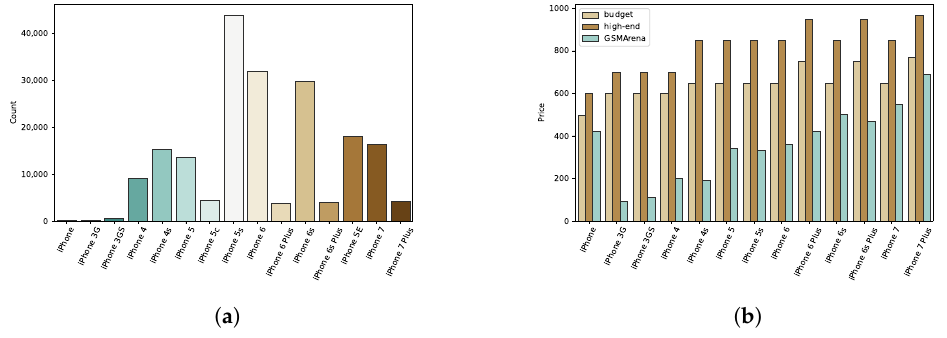
Figure A2. Based on the “April 2017” dataset, the different iPhone models in use are also displayed ( a ), and comparing Apple iPhone prices [63] with the GSMArena-based source [56] ( b ). Versions with the lowest amount of storage are denoted by “budget”, and versions with the most expensive versions are categorized as